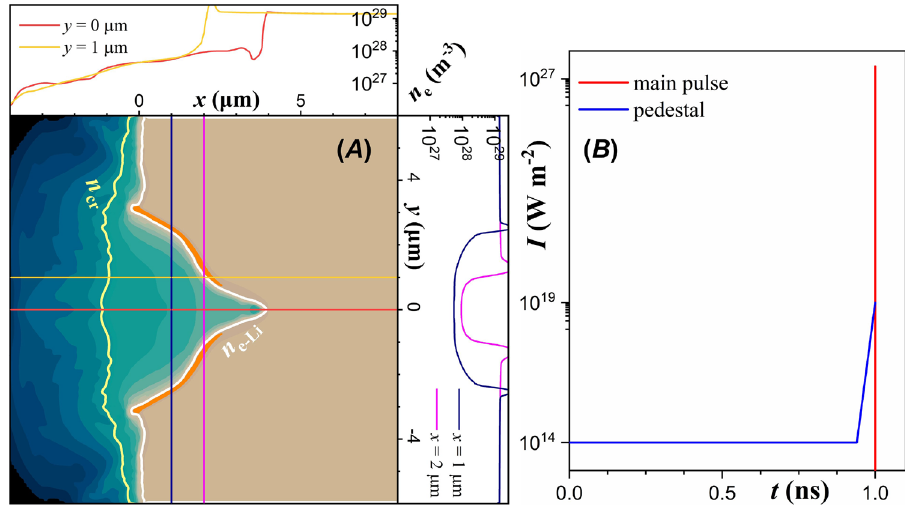
Figure 1. ( A ) Electron number density as given by MHD simulations (data taken from reference 60 ), following irradiation of a lithium foil. The yellow contour line is at the critical density and the white contour line is at the lithium solid electron density. The orange saturated contour is overcritical for laser intensities above 10 ( B ) The ASE pedestal profile used in reference 60 (blue line) compared with the 10PW main laser pulse profile presently employed (red